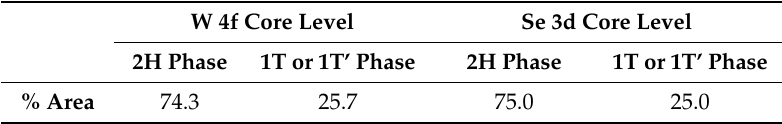
Table 1. Percentages of the corresponding areas of di ff erent phases of WSe 2